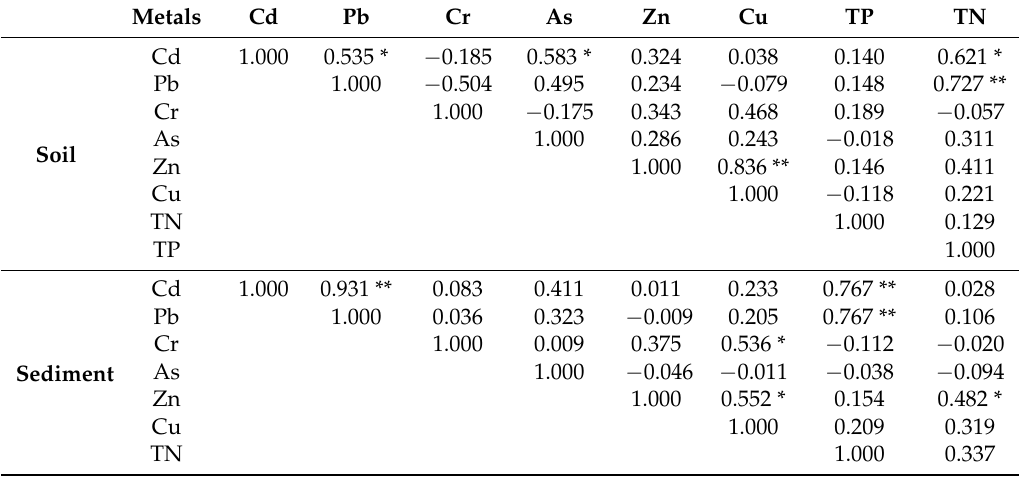
Table 5. Correlation coefficients of potentially toxic element, total phosphorus and total nitrogen concentrations. Metals Cd Pb Cr As Zn Cu TP TN Cd